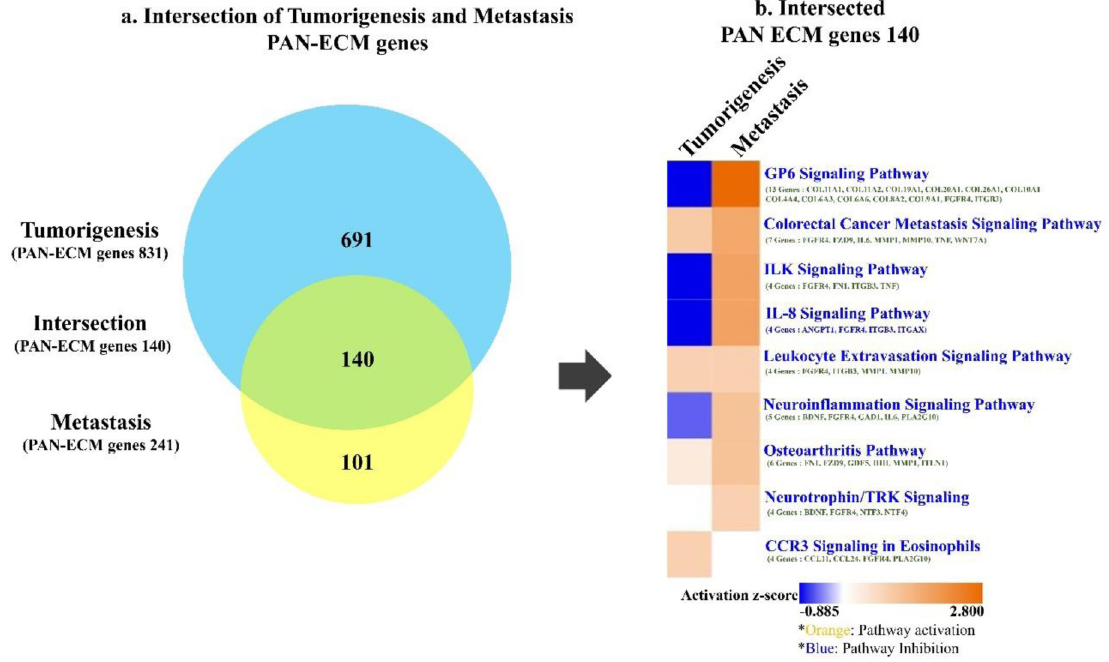
Fig 4. Diagram of the intersecting PAN-ECM genes and their involved canonical pathways in association with tumorigenesis and metastasis of EC by IPA analysis. (a) The diagram shows the PAN-ECM genes in the intersection between tumorigenesis and metastasis. (b) The heat map represents the intersecting PAN-ECM gene involved canonical pathways and their expressions in tumorigenesis and metastasis of EC. The orange color indicates activation of functions/pathways, blue color indicates inhibition of functions/pathways. Intensive color indicates higher absolute